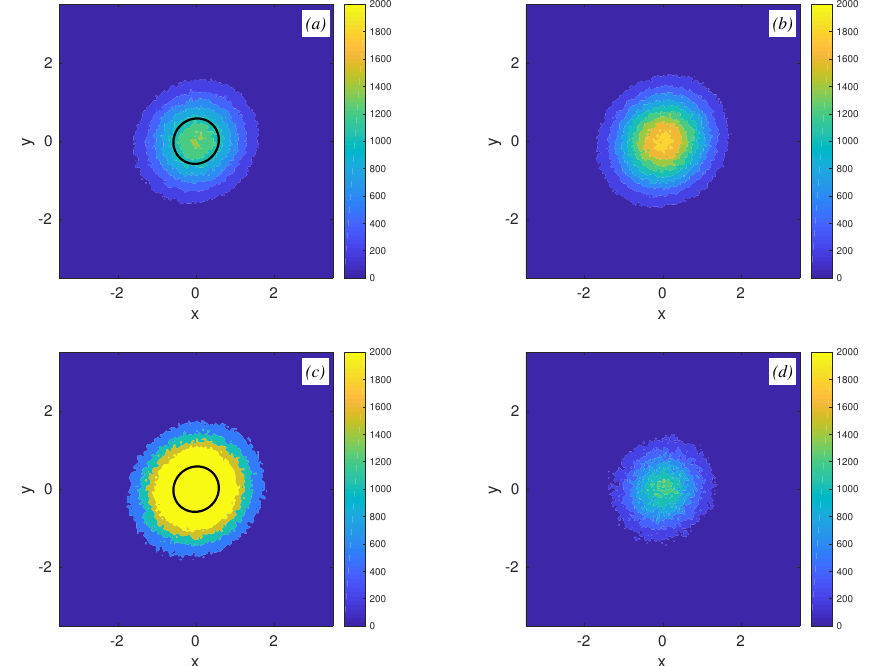
Figure 32. Marker distributions after 40 characteristic time steps out of evenly distributed within the ellipsoid 6 × 10 3 markers for the case of stationary vortex ( (cid:101) ( 0 ) = 1.0551 and ϕ ( 0 ) = − π lines mark the initial distribution boundaries (the ellipsoidal vortex boundary). ( a ) κ z = 2 κ —the surface layer ( z = 0); ( b ) the lower layer of the initial marker distribution; and ( c , d ) same as in ( a , b ), respectively, with switched-off vertical diffusion.